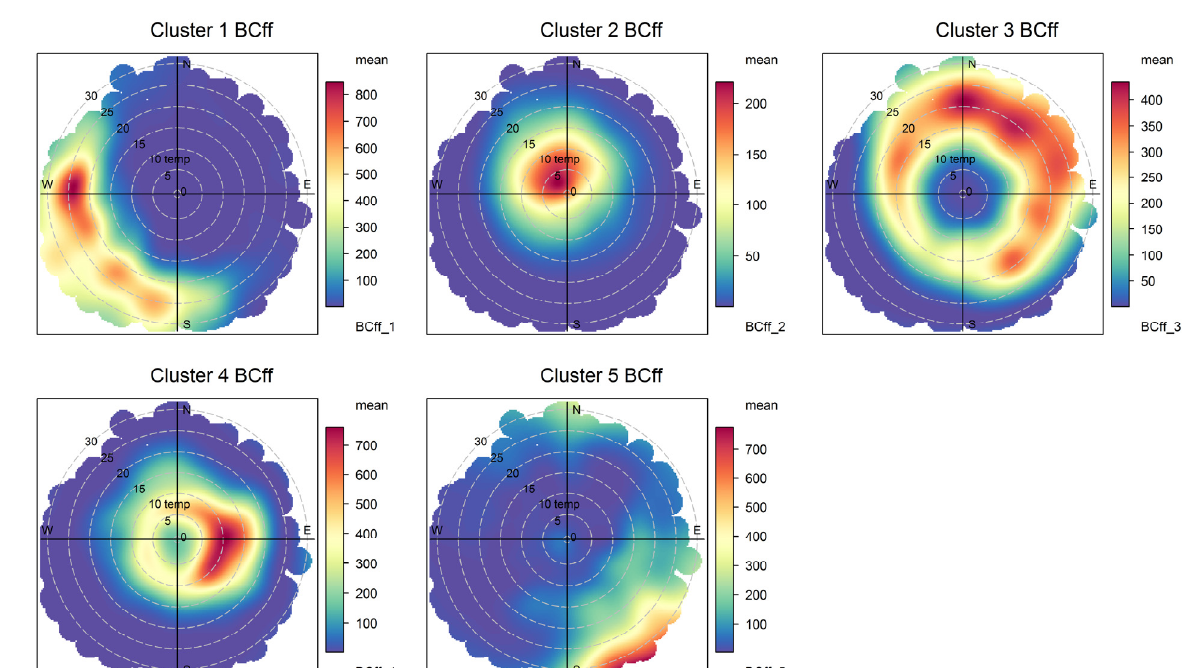
Figure A4. Bivariate plot of hourly BC ff contributions, 2020 campaign, using temperature instead of wind speed.